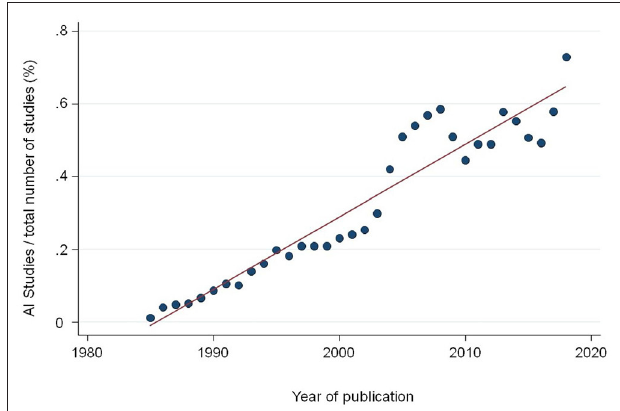
FIGURE 1 | Proportion of studies indexed in Medline with the Medical Subject Heading (MeSH) term “Artificial Intelligence” divided by the total number of publications per year.